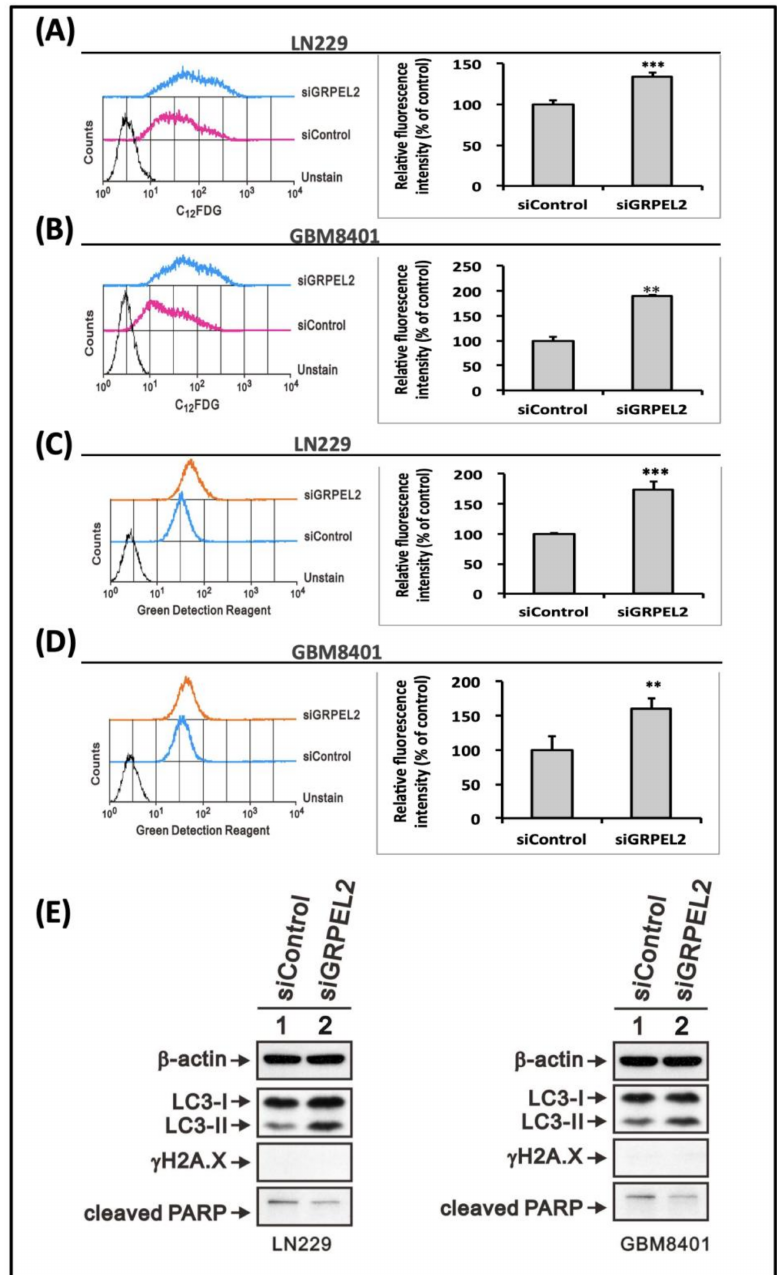
Figure 8. GRPEL2 knockdown impeded cell viability via the enhanced autophagy and senescence of glioma cells. ( A , B ) Flow cytometry-based detection of senescence, LN229 ( A ), and GBM8401 ( B ) cells were exposed to siGRPEL2 for 48 h incubated for C12FDG (5-dodecanoy lamino fluorescein di- β - D -galactopyrano side). Relative fluorescence intensity analyses are shown on the right panel. ** p < 0.01, *** p < 0.001. ( C , D ) Flow cytometry-based detection of autophagy, LN229 ( C ), and GBM8401 ( D ) cells were exposed to siGRPEL2 for 48 h incubated for green detection reagent. Relative fluorescence intensity analyses are shown on right panel. ** p < 0.01, *** p < 0.001. ( E ) Western blotting of autophagy and apoptosis-related proteins in LN229 and GBM8401 cells treated with siGRPEL2 , validating a prominent autophagic increase of the LC3-II to LC3-I ratio compared to the siControl. Note that γ H2AX and cleaved PARP did not change. The images represent the results from three independent experiments. B-actin served as a loading